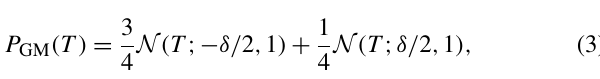
or to the right is chosen. In order to be considered